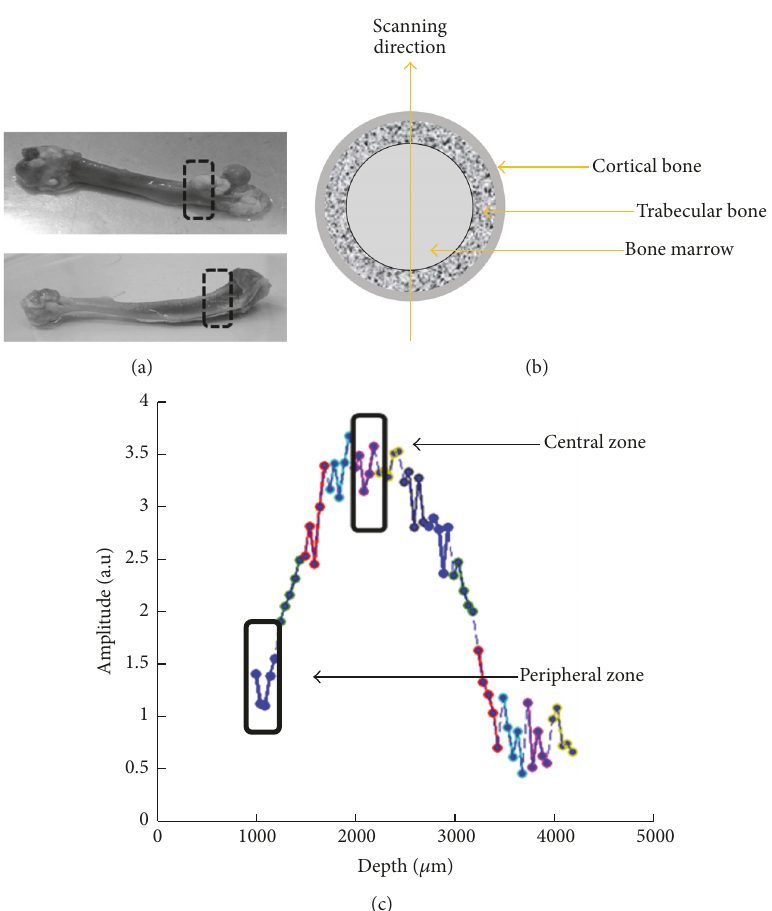
Figure 2: Scanning zones. (a) Scanning regions in proximal tibia and femur metaphysis. (b) Scanning direction in bone cross-section illustration. (c) 3.25 mm depth profile of the proximal tibia diaphysis. Data from different depth scans are marked by different colors. The chosen regions for 𝑇 1 , 𝑇 2 , and ADC measurements are marked at either the center or periphery zones of the